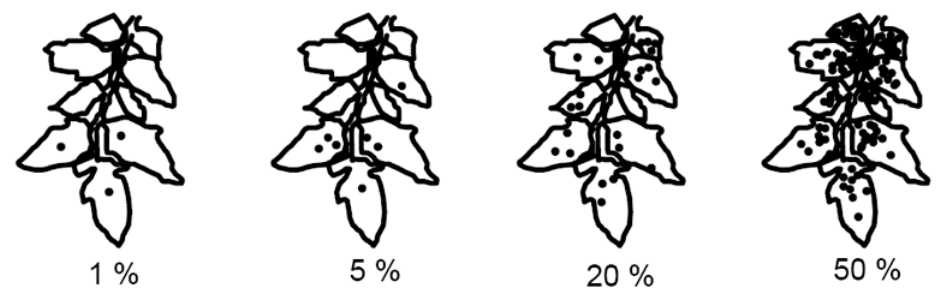
Figure 4. Example assessment of % leaf area infected.